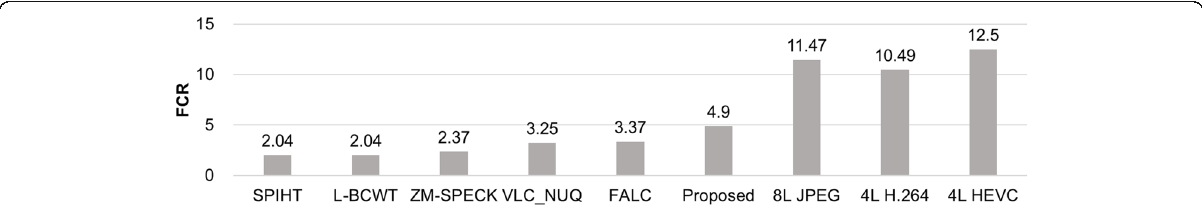
Fig. 13 Average compression ratio results for each compression method (CR compression